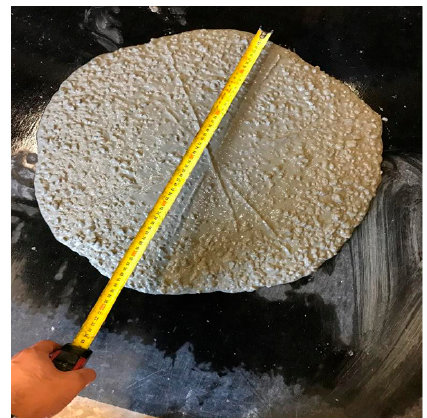
Figure 3. Measuring the slump flow diameter.